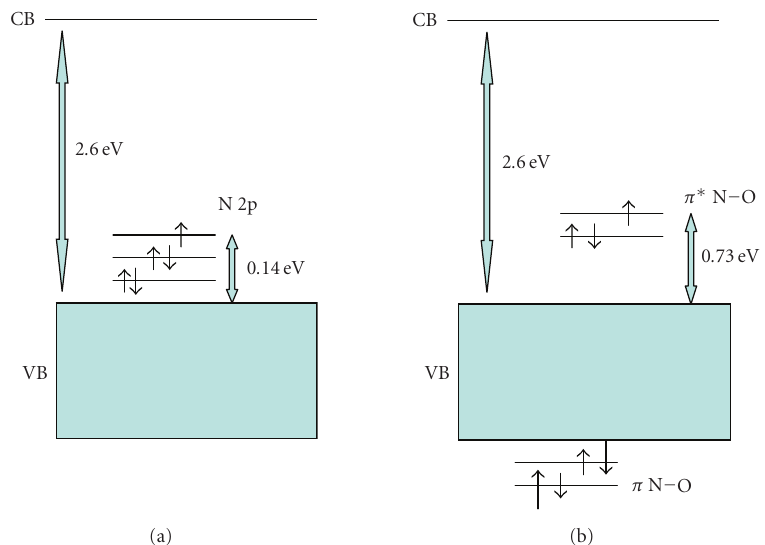
Figure 6: Electronic band structure for (a) substitutional and (b) interstitial N-doped anatase TiO 2 as given by PBE calculations at a low- symmetry k -point. In the former, the site contains the paramagnetic N 2 − species making the site electrically neutral (replaced O 2 − ), whereas in the latter the site is occupied by the radical NO. The estimated band gap energy is also indicated. Reproduced with permission from [48]. Copyright (2005) American Chemical Society.